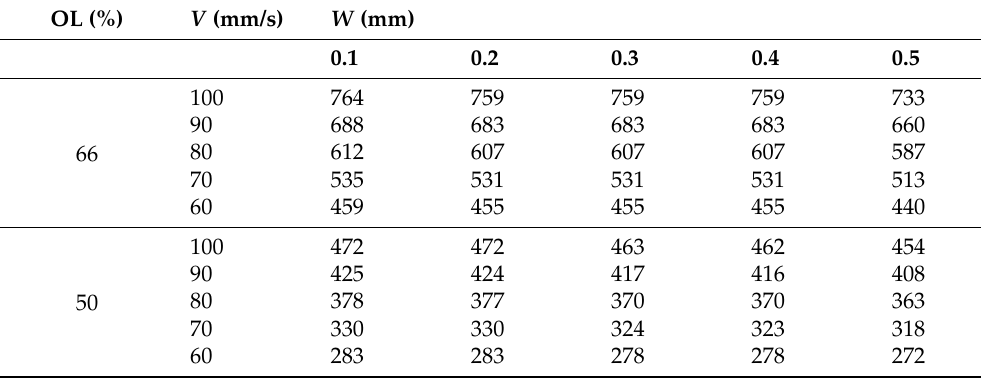
Table 1. Tangential velocity (mm/s) calculation results.